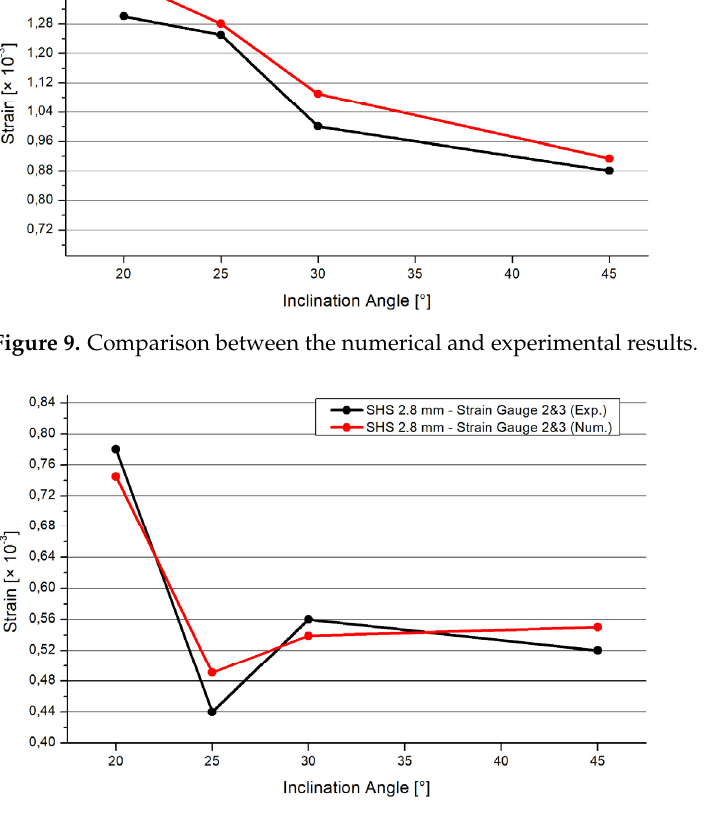
Figure 10. Comparison between the numerical and experimental results. Positions 2 and 3.